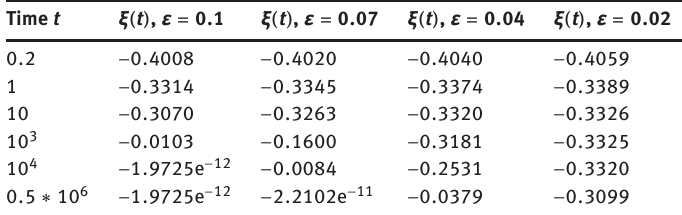
Table 1. The numerical location of the shock layer ξ ( t ) for different values of the parameter ε